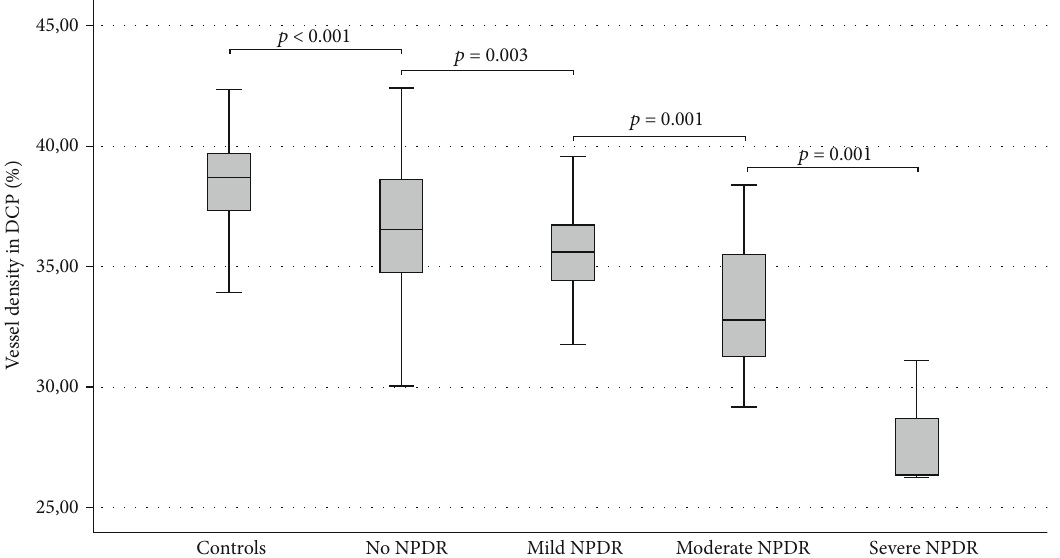
Figure 3: Vessel density in the deep capillary plexus is decreasing with the increasing level of NPDR. Post hoc pairwise comparison between all the subgroups after one-way ANOVA analysis shows a signi fi cant di ff erence in vessel density between each level of